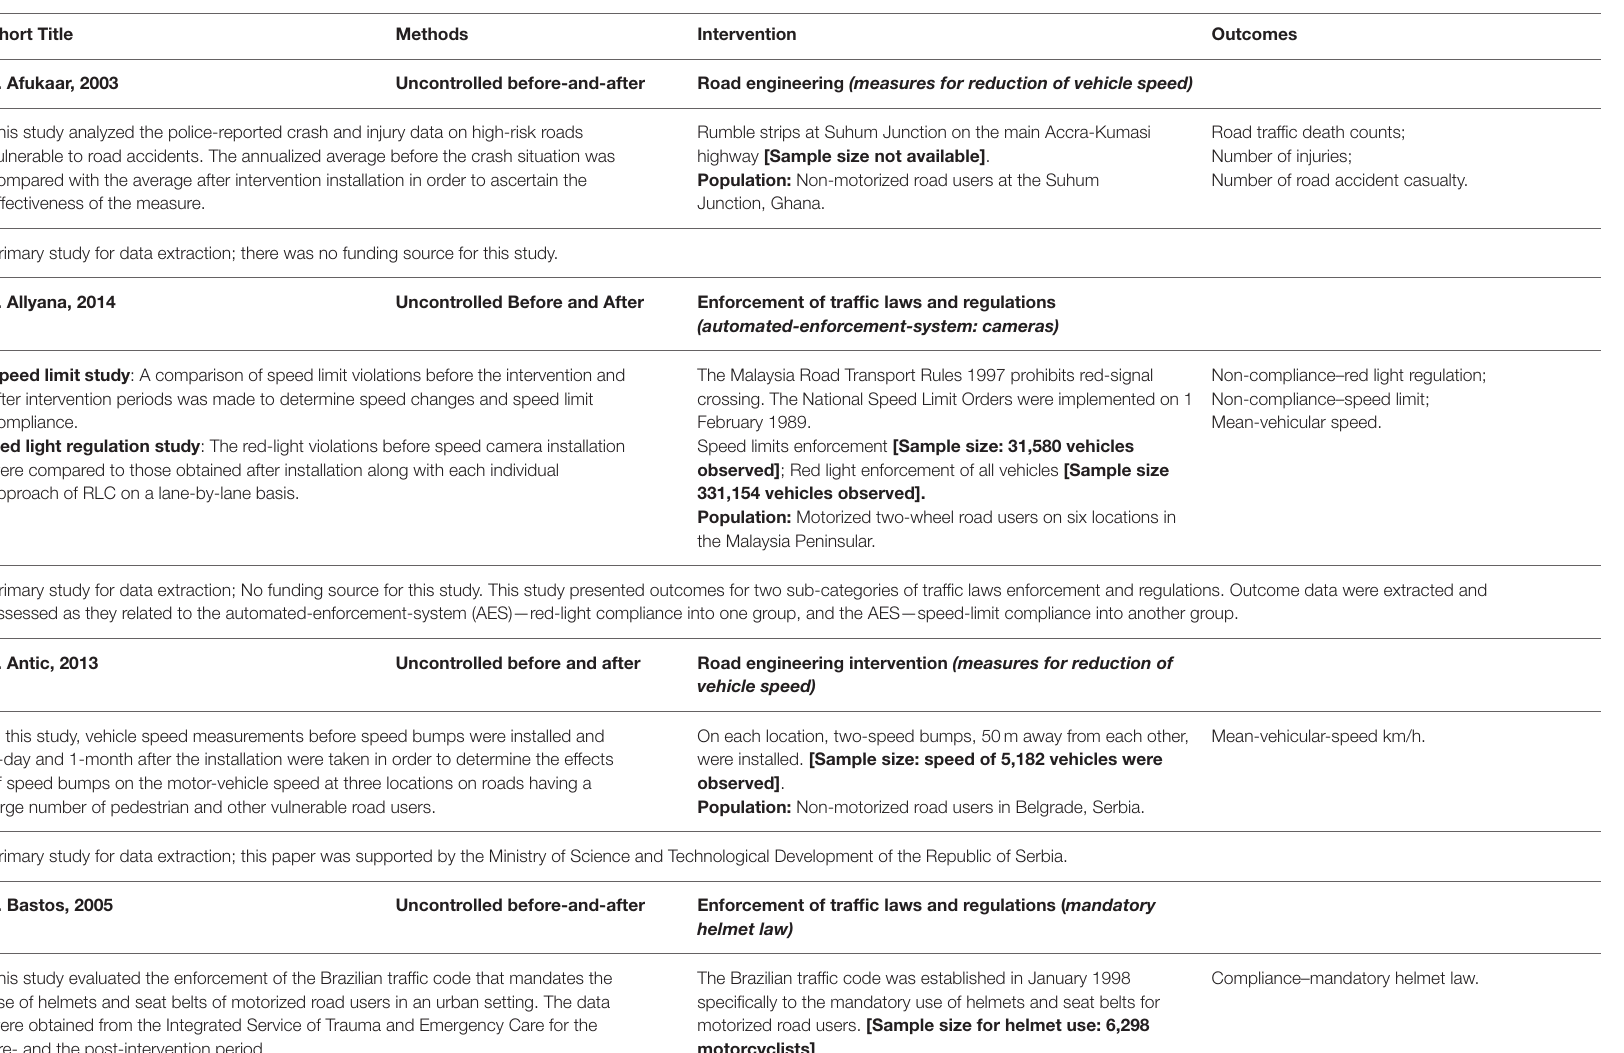
TABLE 1 | Characteristics of studies included for